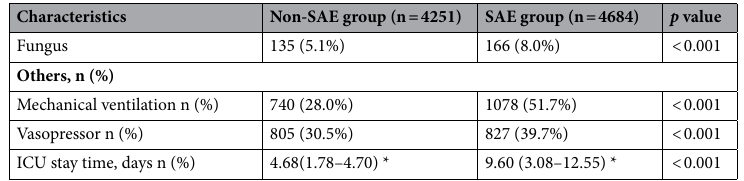
Table 1. Patients’ baseline clinical characteristics at ICU admission. *Presented as median (interquartile range). CCU coronary care unit, CSRU cardiac surgical intensive care unit, MICU medical intensive care unit, SICU surgical intensive care unit, TSICU trauma/surgical intensive care unit, SOFA Sequential Organ Failure Assessment, SAPSII the simplified acute physiology score, GCS Glasgow Coma Score, RDW red blood cell distribution widths, MCV mean corpuscular volume, RR respiratory rate.